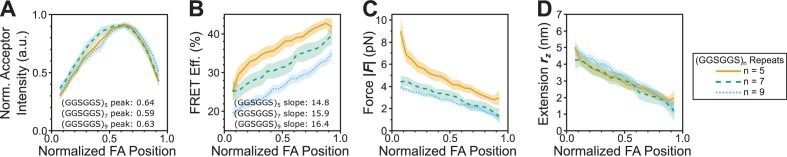
Evaluating gradients in vinculin extension and force at the sub-FA length scale.(A-D) Line scans of single FAs of size >0.5 μm2 and axis ratio >1.5 were compiled and averaged to quantify the spatial distribution of acceptor intensity (A), as well as corresponding FRET efficiencies (B), forces (C), and extensions (D) reported by each of the three distinct tension sensors; shaded region depicts 95% confidence interval for averaged spatial profile; n = 46, 45, 50 FAs from n = 9, 9, 10 cells from three independent experiments.